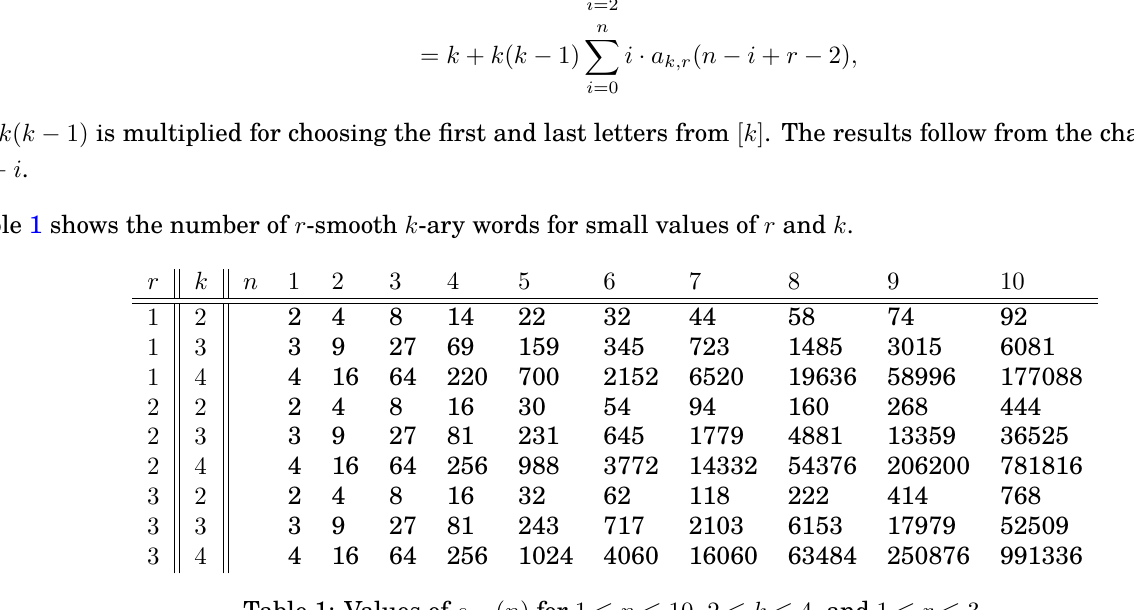
Table 1: Values of s k,r ( n ) for 1 ≤ n ≤ 10 , 2 ≤ k ≤ 4 , and 1 ≤ r ≤ 3